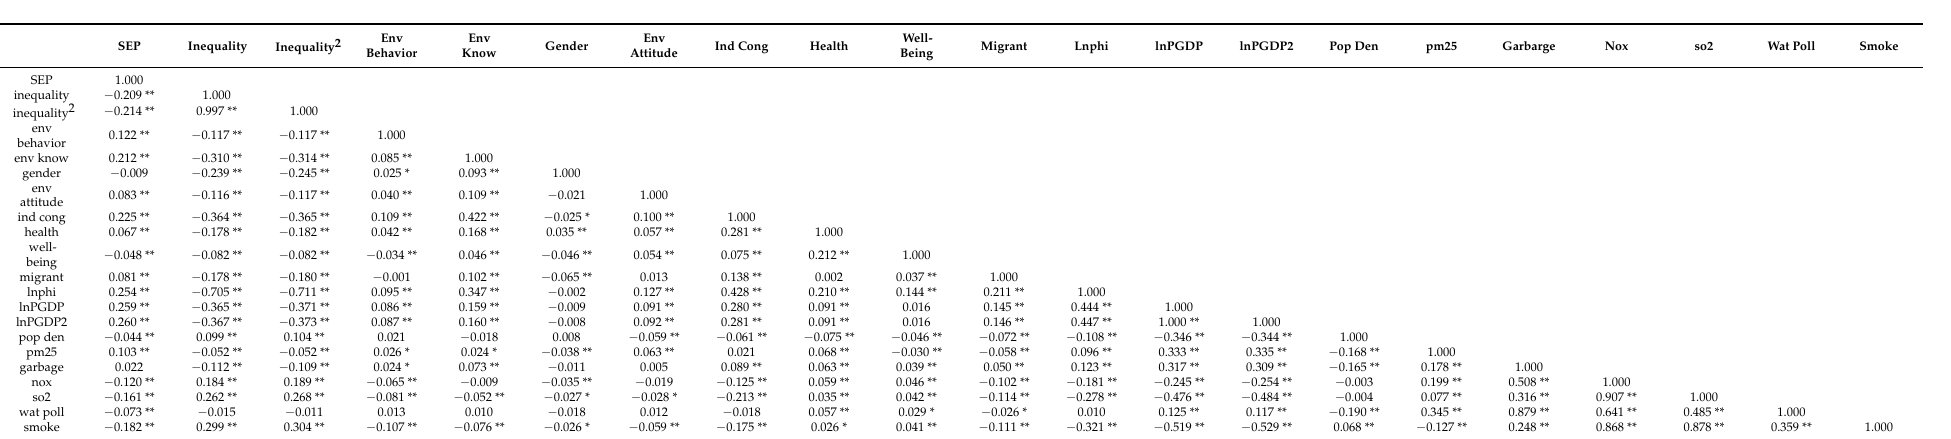
Table A1. Person correlation coefficient